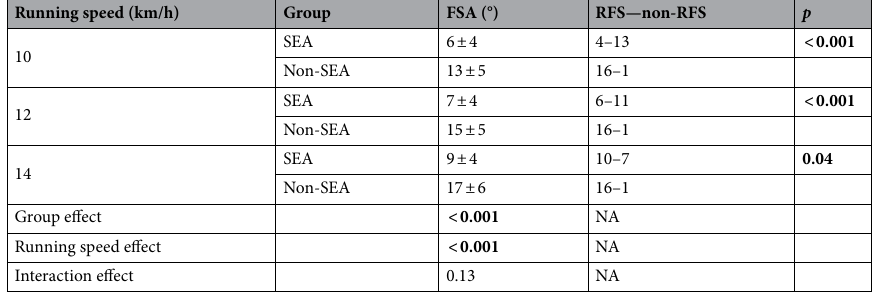
Group effect < 0.001